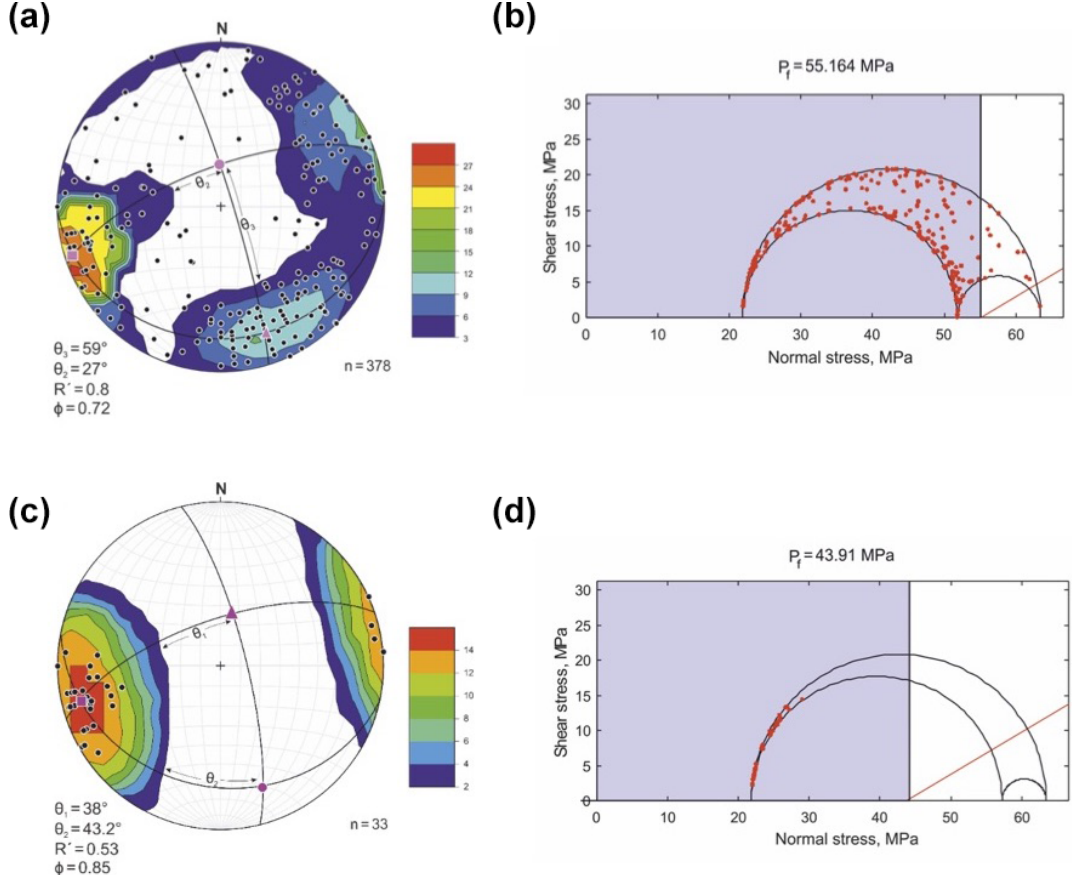
Figure 7. State of stresses and fluid pressure ( P f ) conditions determined from vein orientation data in the study area. (a) Lower hemisphere equal area projection of pole to veins shows girdle distribution, implying P f > σ 2 (following Jolly and Sanderson, 1997). The empty space devoid of any vein pole data helps to determine the position of σ 1 (using Bingham statistics of the Stereonet 9 software) and thereby defines the σ 1 σ 2 and σ 1 σ 3 planes. Angles θ 2 and θ 3 are measured, which are used to determine the stress ratio ( φ ) and driving pressure ratio ( R (cid:48) ), respectively. Color schemes of the legends indicate variation in the contour density. Pink circle ( σ 1 ), pink triangle ( σ 2 ) and pink square ( σ 3 ), respectively. (b) 3-D Mohr circle diagram for high- P f conditions. Red line in the Mohr circle represents the reactivation envelope for cohesionless fractures. Vein pole data lying within the blue zone, i.e., to the left of the P f (black) line, represent fractures filled up with veins that are prone to reactivate (Fractend code available via Healy, 2017). (c) Lower hemisphere equal area projection of poles to vein data forming the WSW cluster in (a) ; this cluster distribution of vein pole data indicates P f < σ 2 . Cluster maxima define the σ 3 axis. Angles θ 1 and θ 2 are measured and, similarly, φ and R (cid:48) are determined. (d) 3-D Mohr circle diagram for a low- P f condition. Only a limited range of fractures filled up with veins are prone to reactivate. Red dots represent pole to vein data and the red line forms the reactivation envelope for cohesionless fractures. n : number of